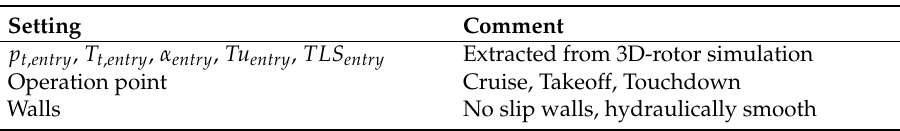
Table 2. Boundary